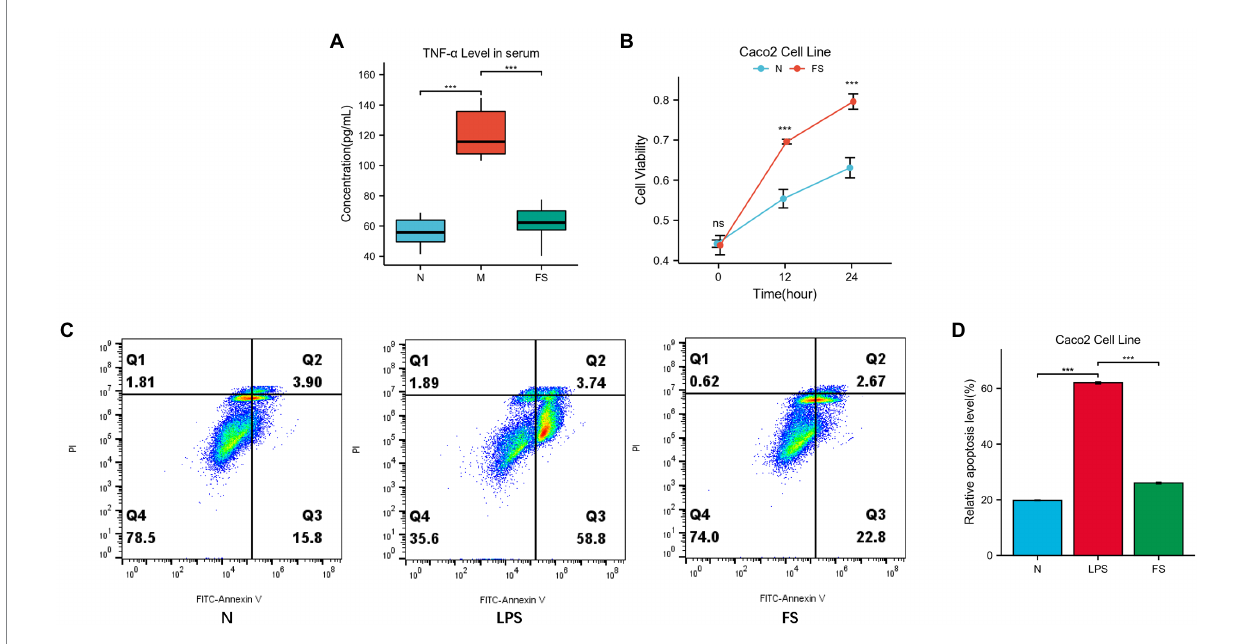
FIGURE 4 Postbiotic of hawthorn-probiotic help preserve the intestinal barrier. (A) The concentration of TNF- α in mice’s serum (pg/mL) by using Elisa; (B) Caco2 cells viability in normal and 5% postbiotic treated (FS) groups by using CCK8; (C,D) Caco2 cells relative apoptosis level (Q2 + Q3). NS; * p < 0.05; ** p < 0.01; *** p <